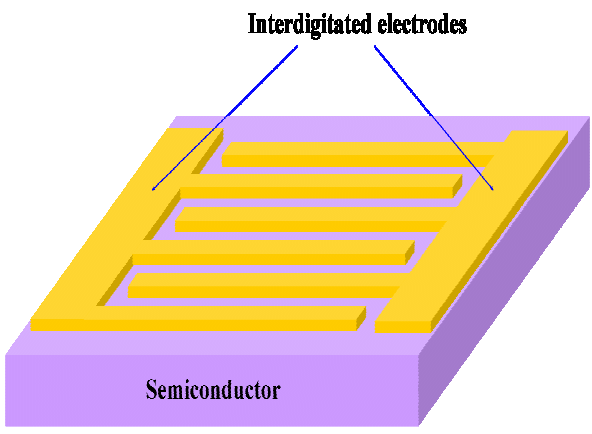
Figure 3. A schematic image of an MSM photodiode